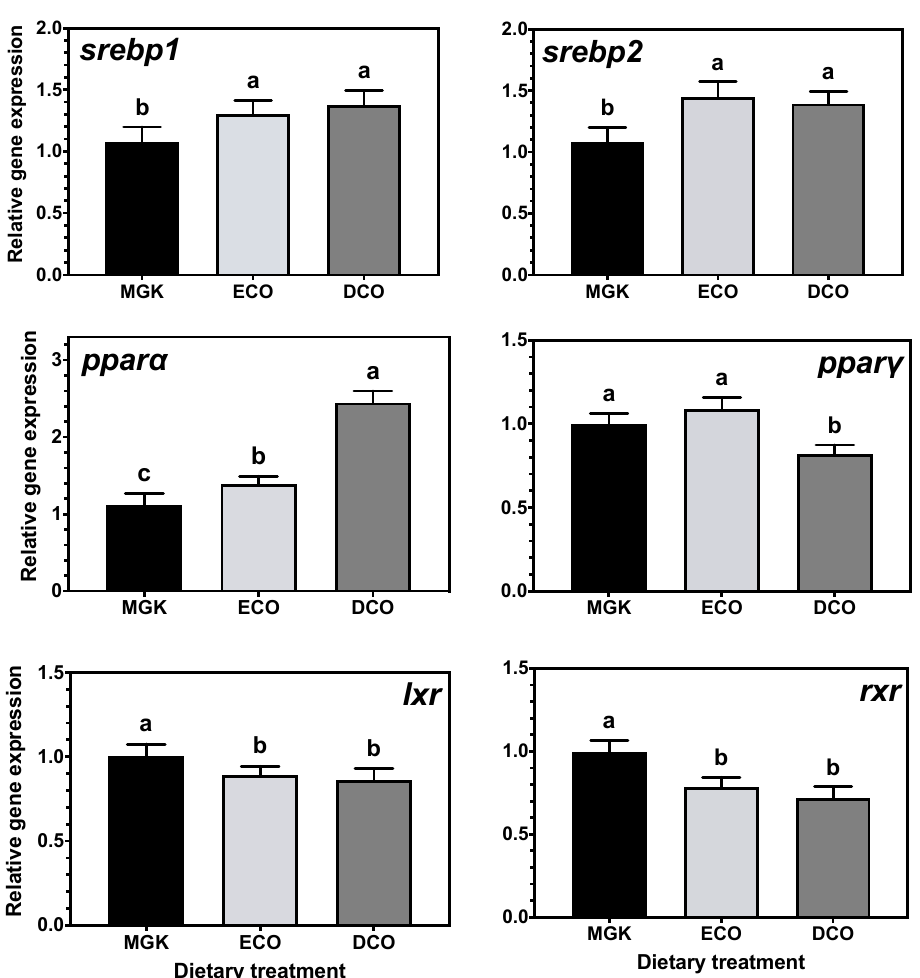
Figure 5. Nutritional regulation of sterol regulatory element-binding protein 1 and 2 ( srebp1 and srebp2 respectively), peroxisome proliferator-activated receptor alpha ( ppar α ) , gamma ( ppar γ ) , liver X receptor ( lxr ) and retinoid X receptor ( rxr ) gene transcription in liver of Atlantic bluefin tuna ( Thunnus thynnus L.) juveniles fed a reference diet Magokoro ® (MGK) and two test diets containing either EPA (ECO) or EPA + DHA (DCO) oils from transgenic Camelina sativa seeds. Values are normalised expression ratios to MGK reference diet and are means ± SD ( n = 6). Values with different superscript letters are significantly different (one-way ANOVA and Tukey test; p < 0.05).